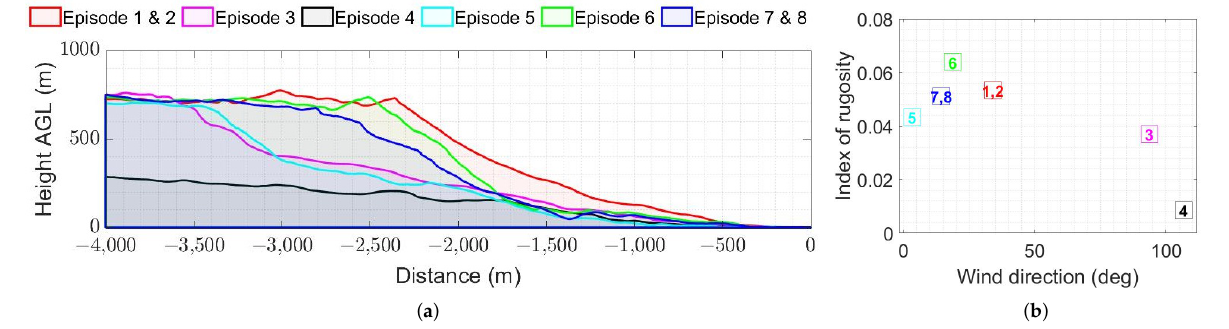
Figure 5. ( a ) Upstream terrain elevation profiles along the prevailing wind direction towards the measurement site for selected wind episodes. ( b ) The complexity of terrain with regard to prevailing wind directions of selected wind episodes, expressed by the index of rugosity